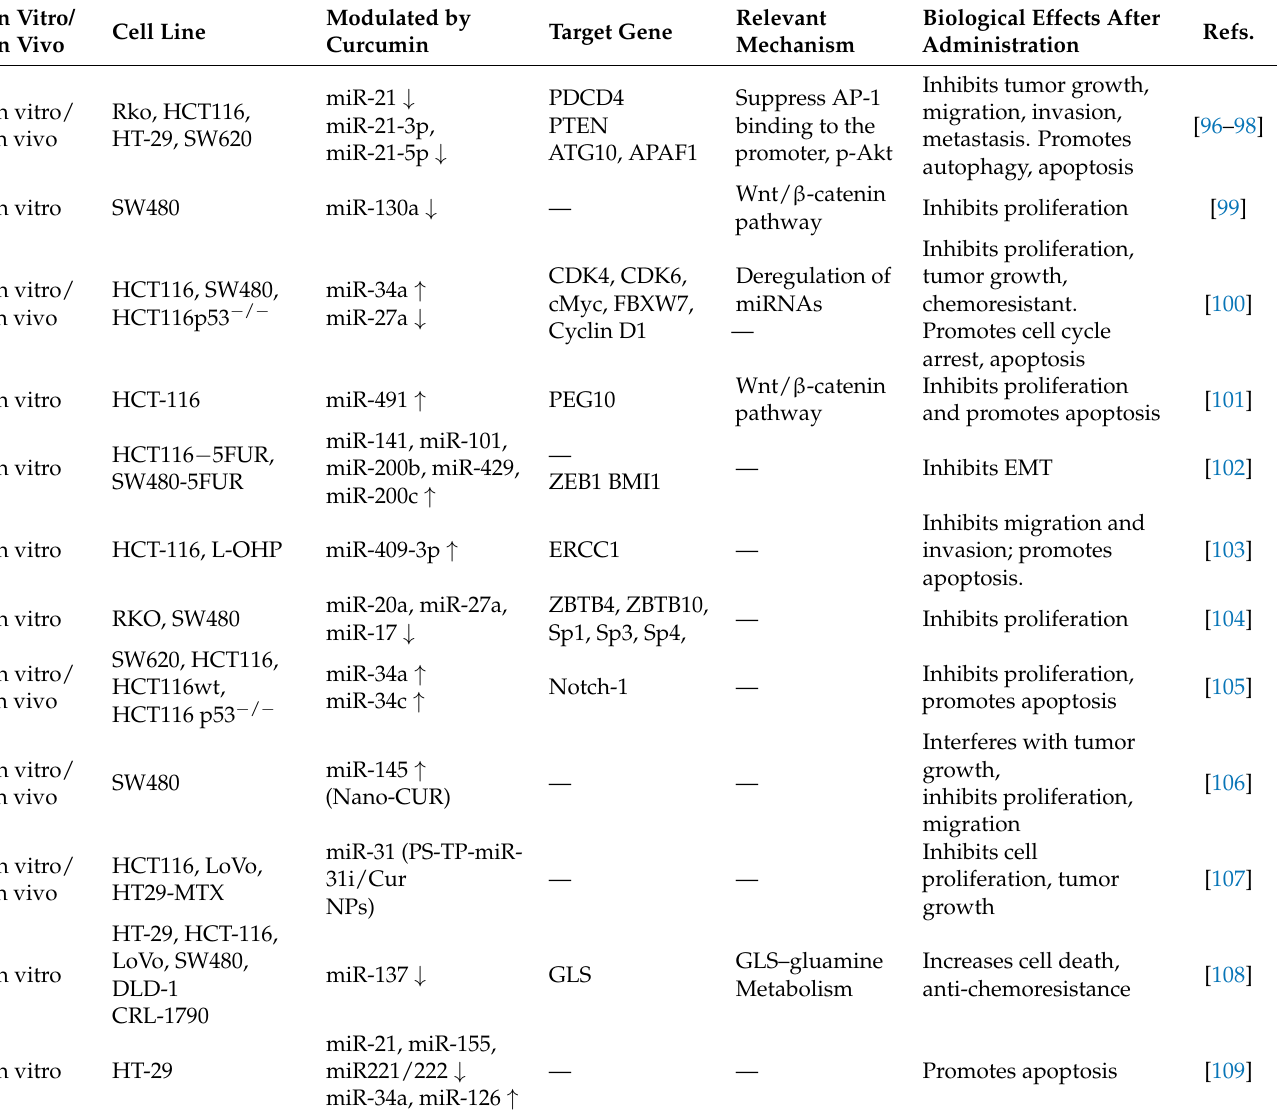
Table 1. Curcumin modulates miRNAs in colorectal